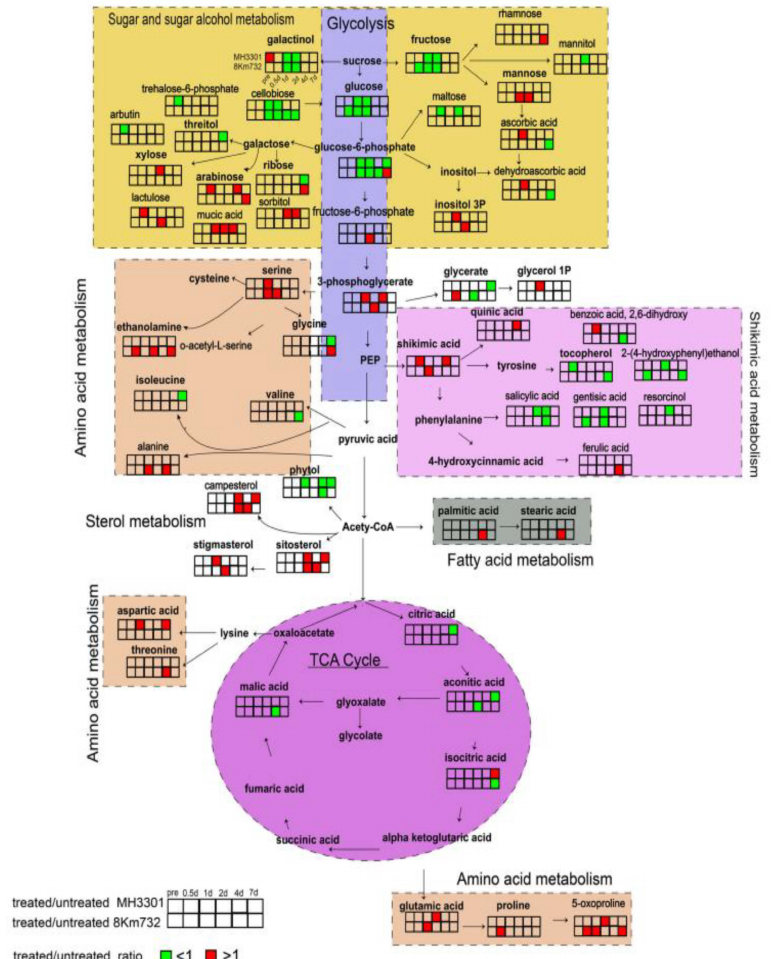
Figure 3. Pathway analysis of differential metabolites related to pesticide stress of rice leaves (MH3301 and 8Km732). The metabolic response indicates relative metabolite levels of the treated group against the control group (treated/untreated) at the same time point. Red (treated/untreated > 1) and green (treated/untreated < 1) represent a p -value of metabolite less than 0.05 between treated and untreated groups, while white reflects a p -value more than 0.05 (colour figure online). Adapted from Zhao et al. [35] Springer Nature Publishing group